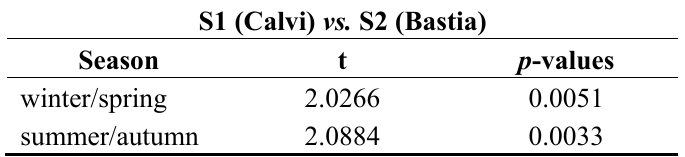
Table 3. Pair-wise tests for the interaction term between sites and seasons, with comparisons between sites S1 and S2 within the winter/spring and the summer/autumn terms of